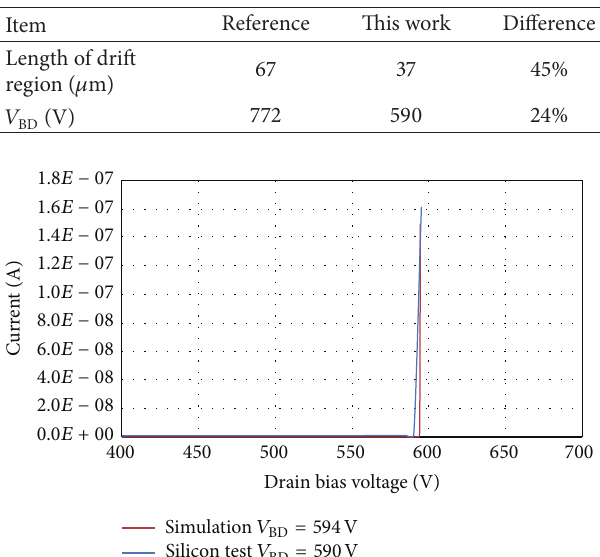
Table 3: Comparison of reference NLDMOS and this work.